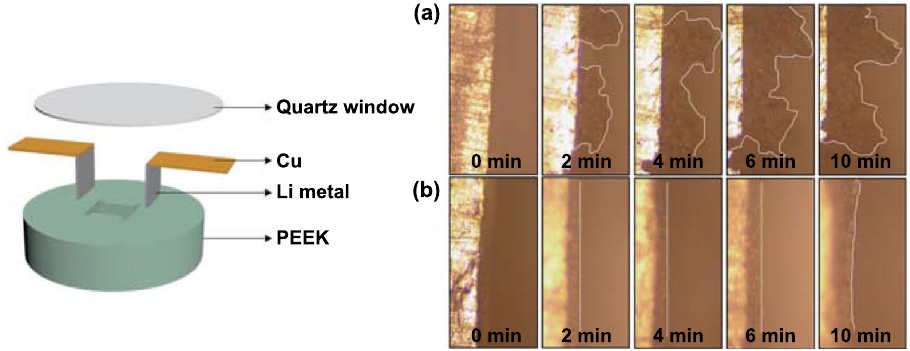
Fig. 4 In situ optical microscopy observations of Li metal deposition with different electrolytes at the current density of 2 mA cm −2 : a 1 M LiPF 6 in EC/DEC (1:1 v/v) and b LBT-1